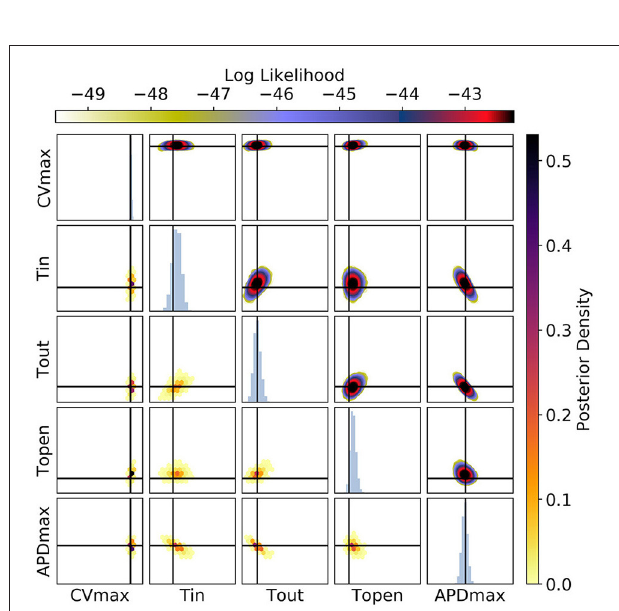
FIGURE 13 | The posterior parameter distribution for calibration to CV(S2), APD(S2), and ERP(S1) measurements simultaneously. The intersection of vertical and horizontal lines mark the true parameter value. The lower diagonal shows the density via hexbin plots, while the upper diagonal shows the log likelihood values for each sample plotted in order of increasing likelihood. The diagonals show the marginal histograms of each parameter.